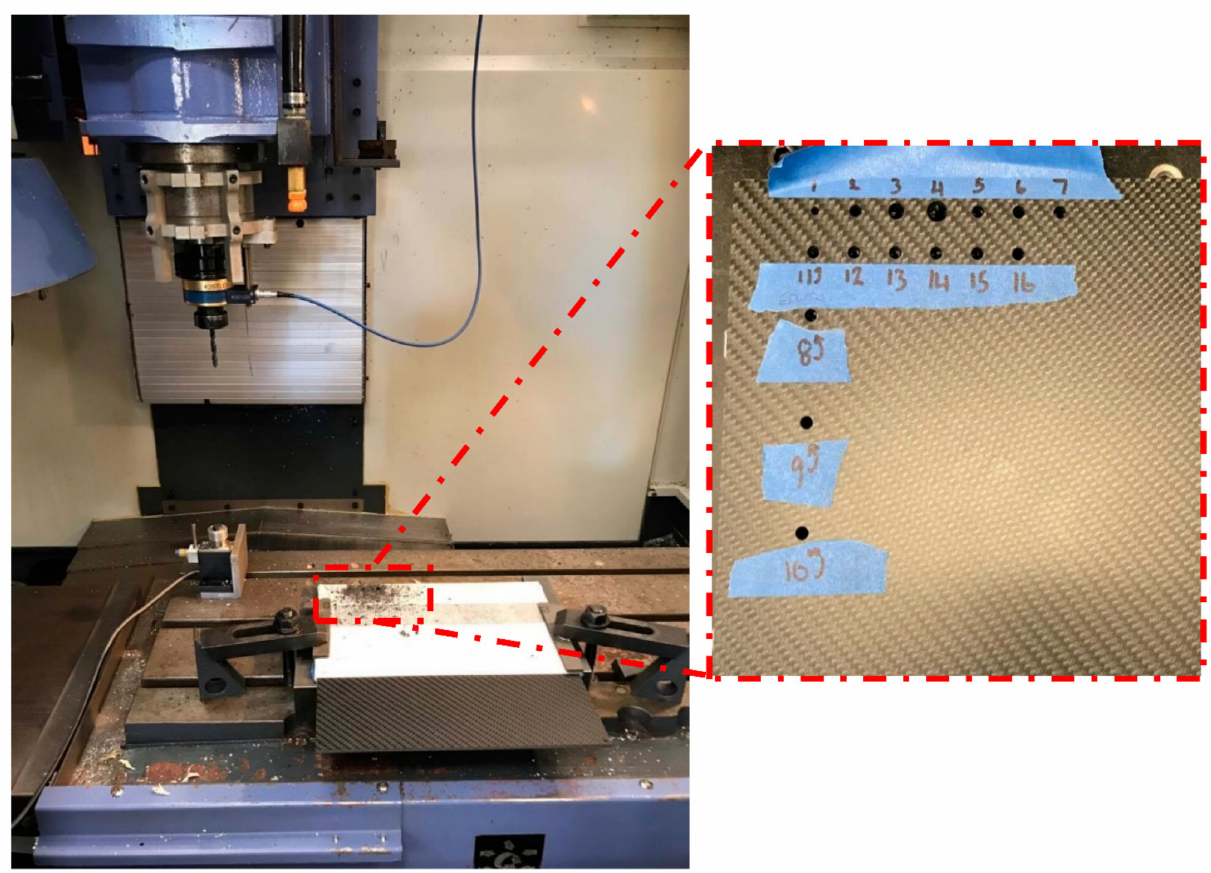
Figure 1. Experimental set-up for drilling of